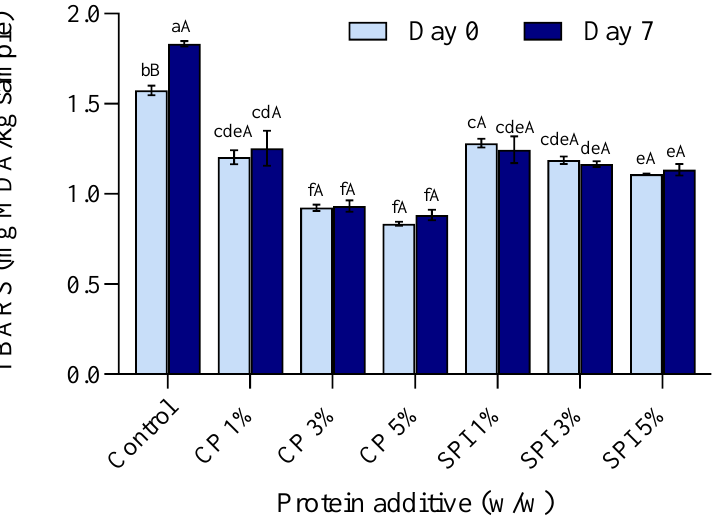
Figure 7. Changes of lipid oxidation assessed by thiobarbituric acid reactive substances (TBARS) of mackerel surimi gels prepared using the addition of cricket powder (CP) and soy protein isolate (SPI) at Day 0 and Day 7 of refrigerated storage (4 °C). Bars represent standard deviation from triplicate determinations. Different lowercase letters across all samples and different uppercase letters between storage times at the same level of additive indicate significant differences ( p < 0.05).